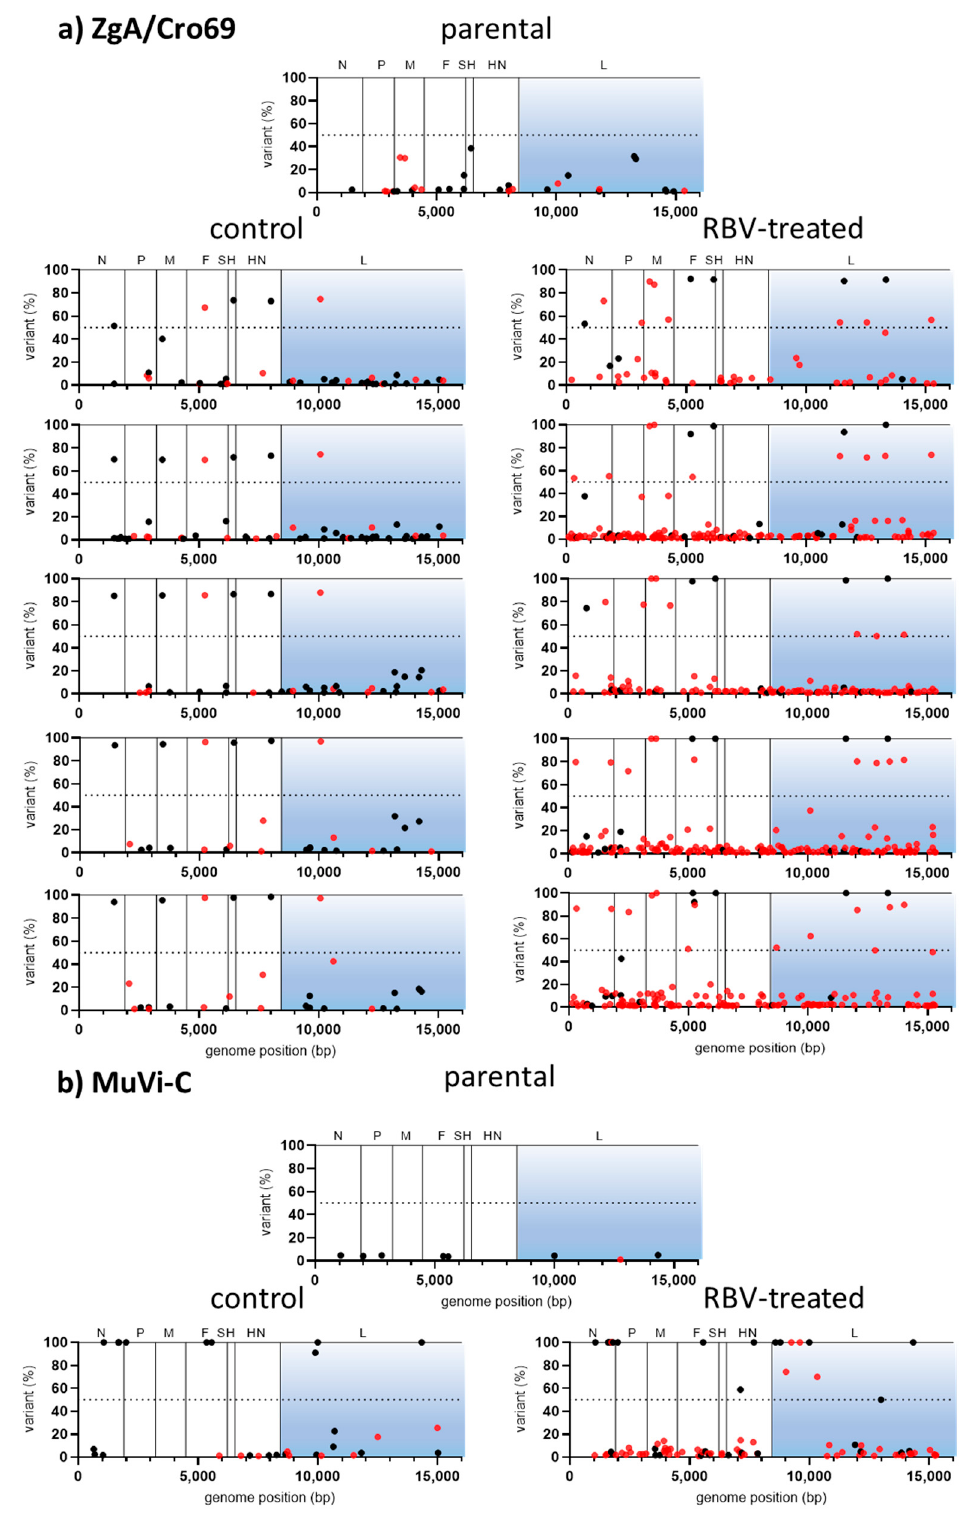
Figure 5. Variant frequency (%) in parental and RBV-treated (62.5 µ M) or control ( a ) ZgA/Cro69 and ( b ) MuVi-C viruses from different passages in A549 and Vero cells, respectively, according to their location in the genome. RBV-specific mutations (C-to-U and G-to-A) are shown by red dots and all other mutation types by black dots. Dashed lines indicate a value of 50%; changes present in values higher than 50% are consensus changes. The L gene, where resistance-/fidelity-related mutation/s are expected to emerge, is given in blue. Only variants present in >1% are shown.